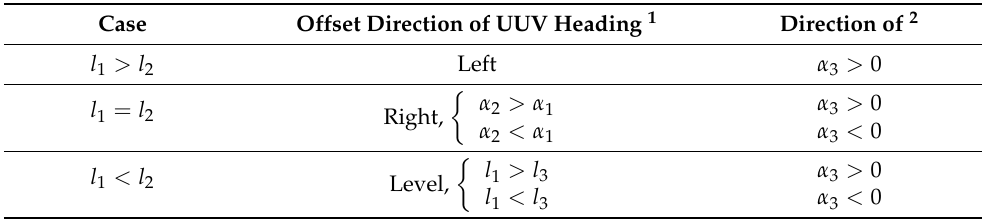
Table 3. Table of direction decision of α 3